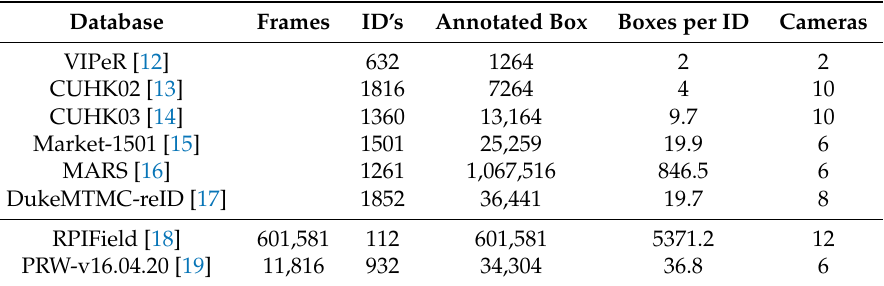
Table 1. Comparing existing re-ID